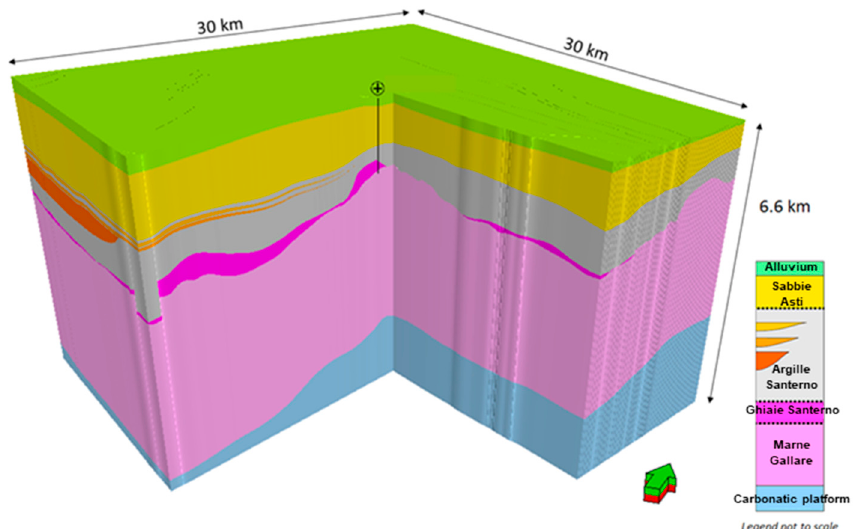
Figure 2. ( a ) Simplified structural map of the Po Valley around the modelled area. ( b ) SO-NE section through the alpine thrust structures. ( c ) SSE-NNO section intersecting the Apennine (SSE) and Alpine (NNO) thrust belts (after Reference [25]).